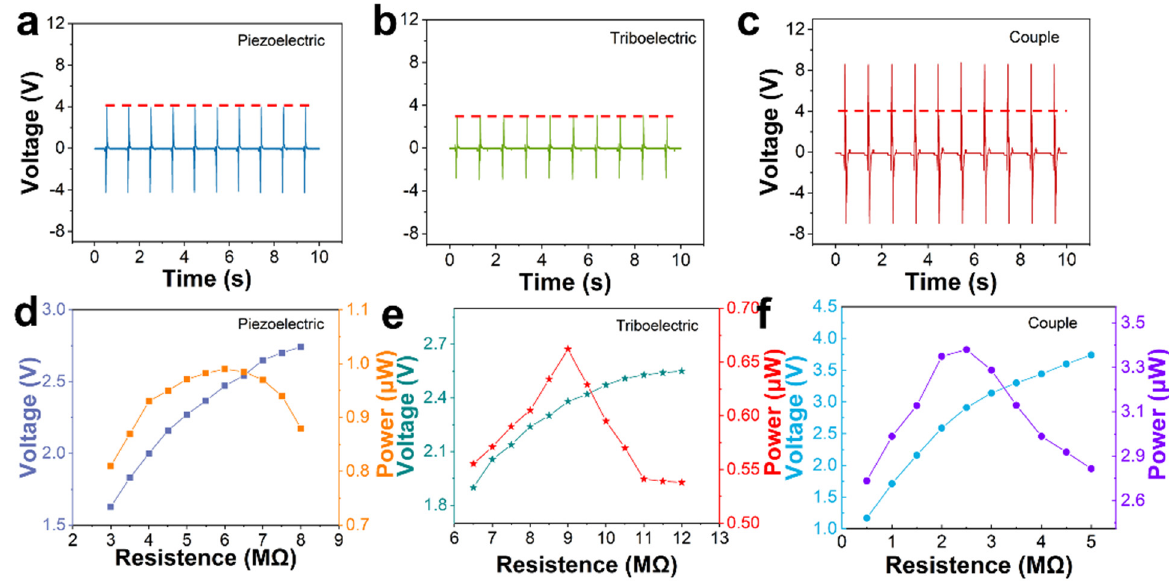
Figure 3. Electrical properties of PENG, TENG, and PTSS in a 100% RH environment. ( a – c ) Comparison of output voltages of PENG, TENG and PTSS. ( d – f ) Power and outputting voltage of PENG, TENG, and PTSS at different load resistances.